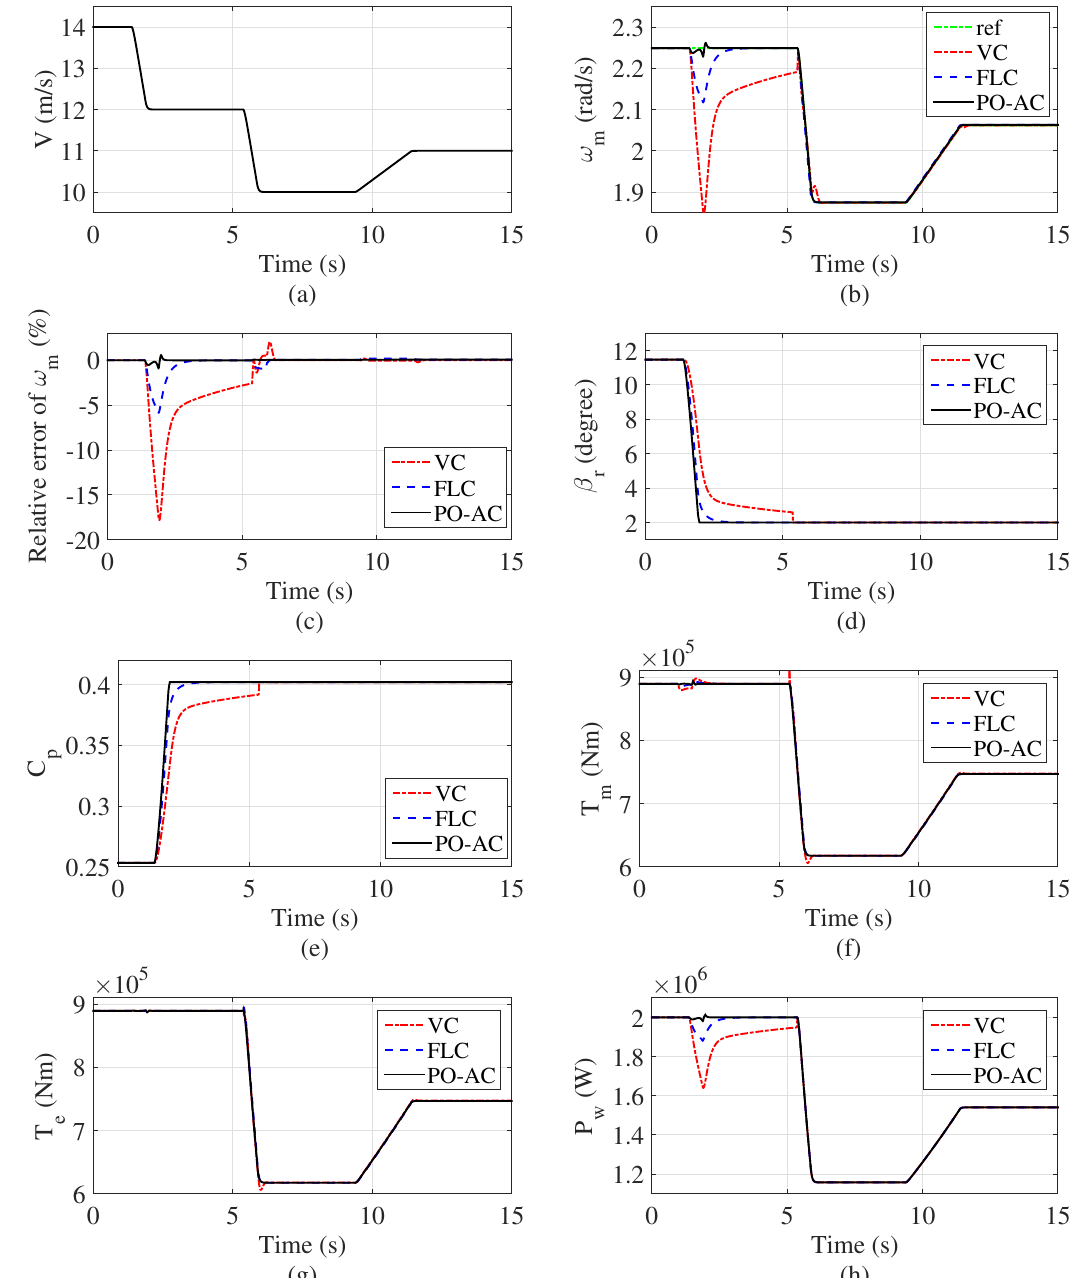
Figure 4. Responses of the WT to ramp wind speed. ( a ) Wind speed V. ( b ) Mechanical rotation speed ω m . ( c ) Relative error of mechanical rotation speed ω m . ( d ) Pitch angle reference β r . ( e ) Power coefficient C p . ( f ) Mechanical rotation torque T m . ( g ) Electromagnetic torque T e . ( h ) Mechanical power P w